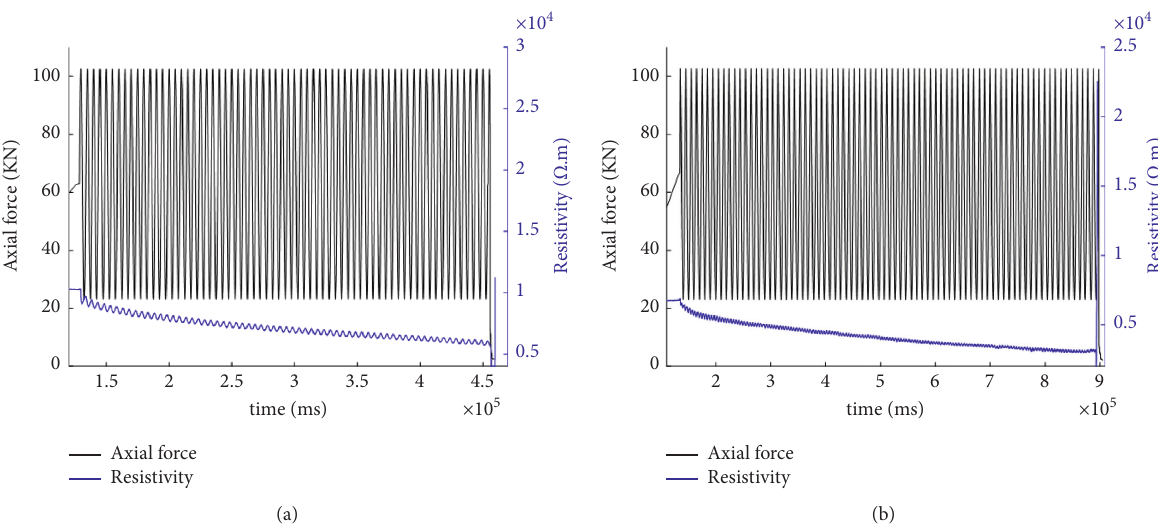
Figure 8: Resistivity evolution law: (a) evolution law of resistivity of specimen 1; (b) resistivity evolution law of specimen